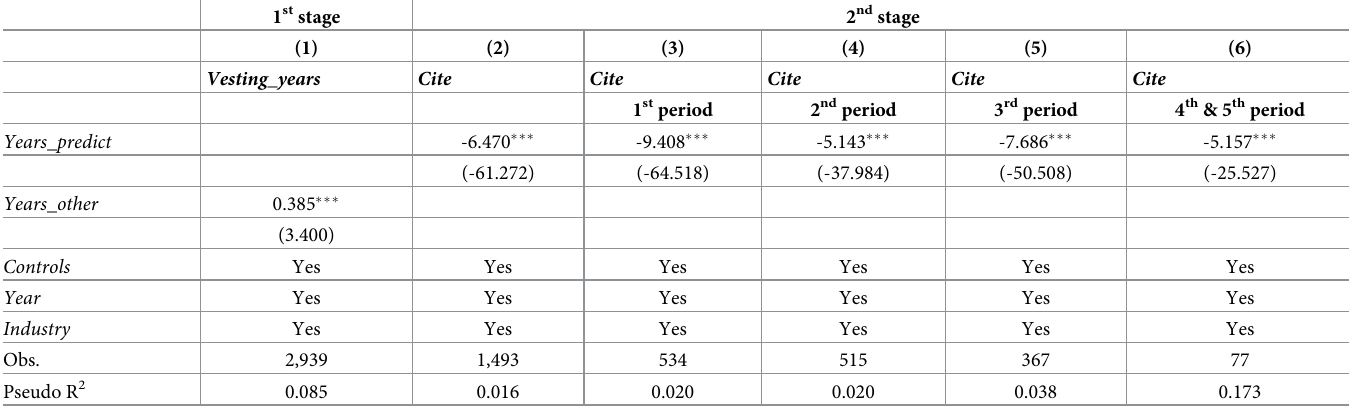
Table 4. Instrumental variable